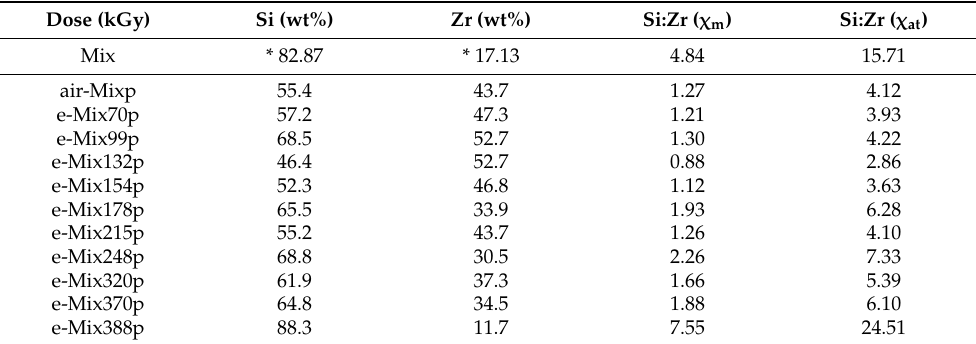
Table 4. Si and Zr content in (air/e-)Mix samples after post-curing processing, normalised to 100% and Si:Zr mass and atomic fraction ( χ m and χ at